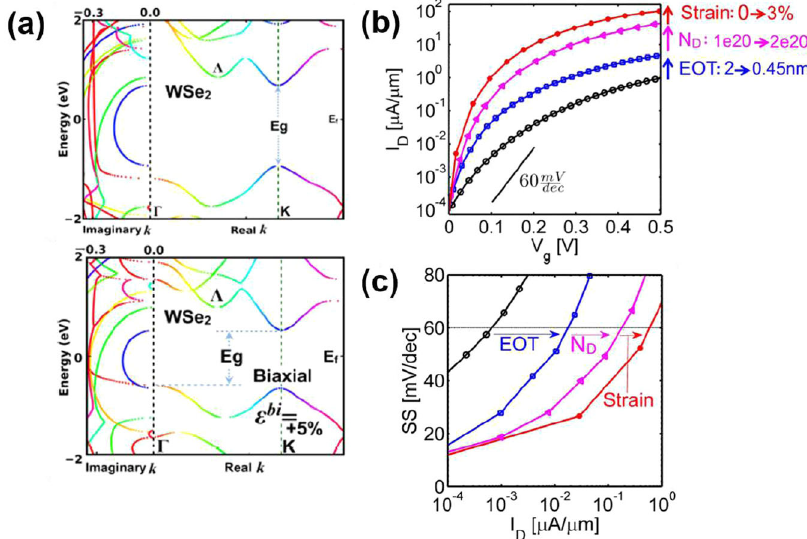
Fig. 13 Simulation Report of Nanoscale 2D TMD-TFET. a Plots of E-k dispersion relation of monolayer WSe 2 with and without applied biaxial tensile strain, adapted with permission from 90 . Copyright (2013) IEEE, b transfer characteristics and c SS-I on plot of monolayer WSe 2 – TFET with and without applied biaxial tensile strain, adapted with permission from 97 . Copyright (2016) IEEE.